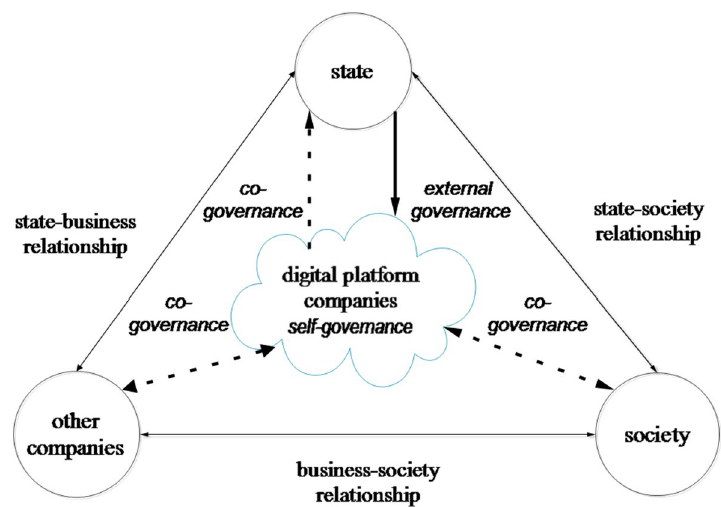
Fig. 1 The field of digital platform